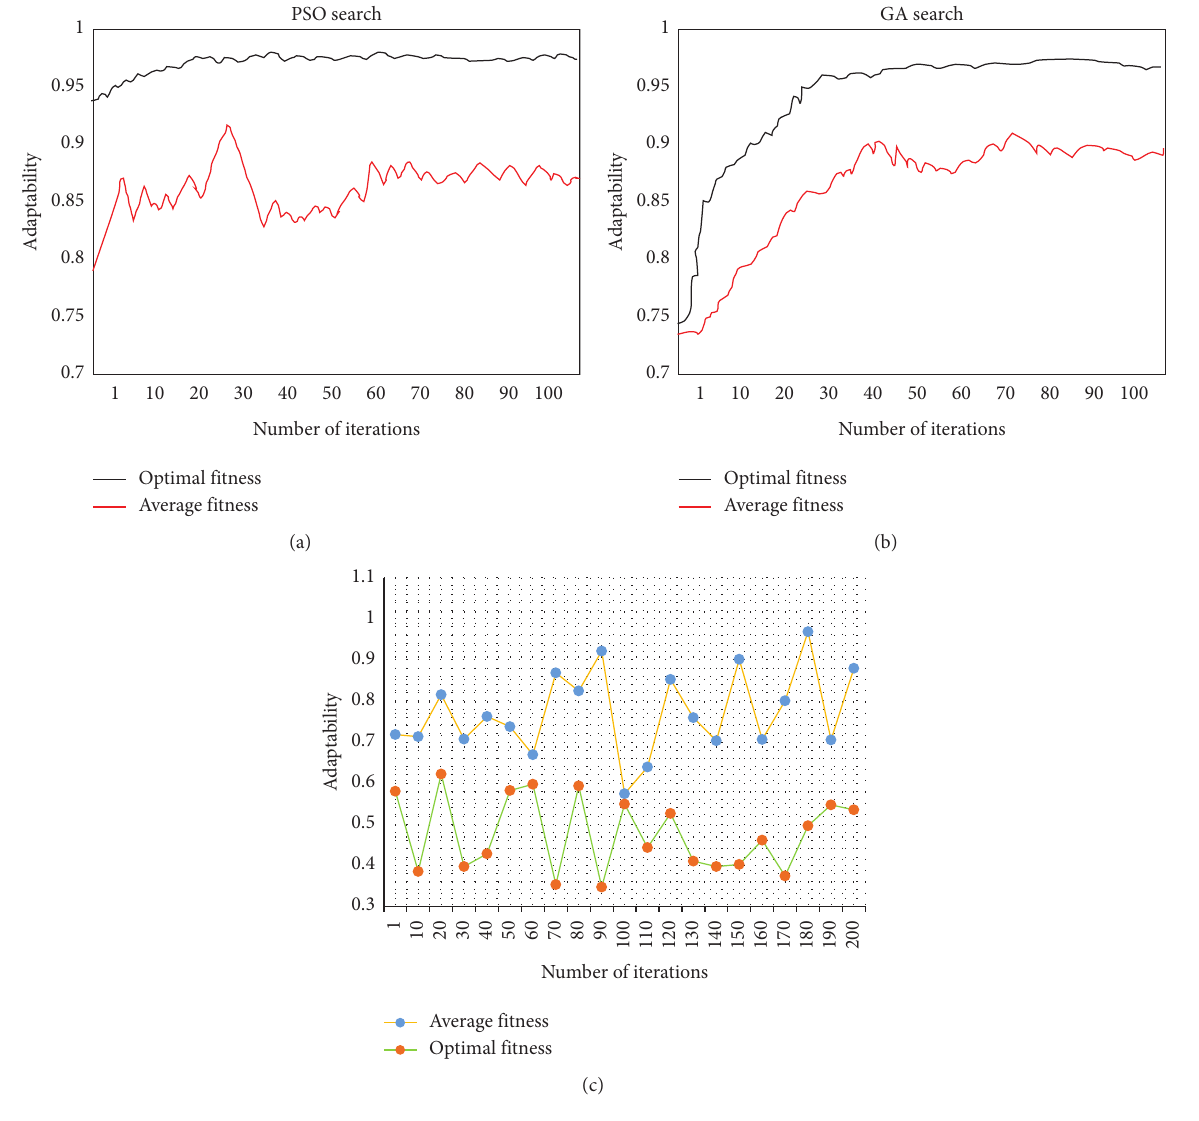
Figure 9: Fitness convergence